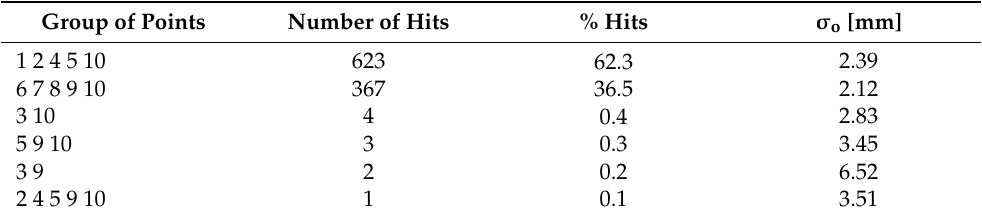
Table 4. Results of identification of the stability of reference system by the Hooke-Jeeves method for the test object 1.